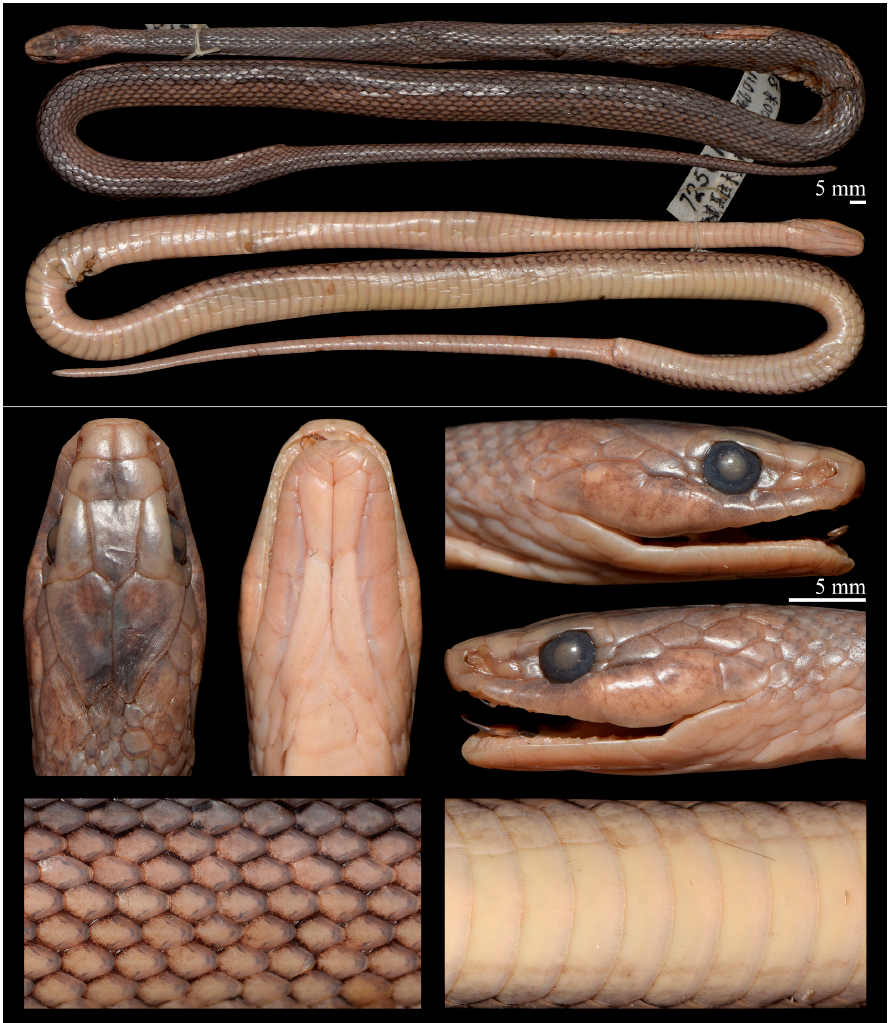
Figure 4. Preserved specimen of Herpetoreas cf. platyceps , CIB 8420, adult female, Nyalam County, Xizang Autonomous Region, China. Photographs by Jun ‐ Jie Huang. Figure 5 Herpetoreas sieboldii Günther, 1860, Proc. Zool Soc. London , 28 (1): 156–157 [38]. Type locality: “Sikkim, Himalaya (7500 feet above the level of the sea)” [=Sikkim State, North ‐ east India, elevation 2,286 m a.s.l.].